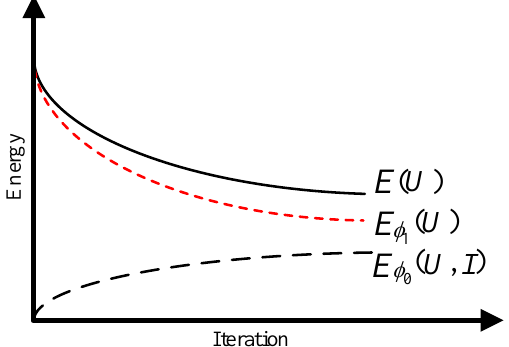
Figure 1. Regularization-dominated variational models.